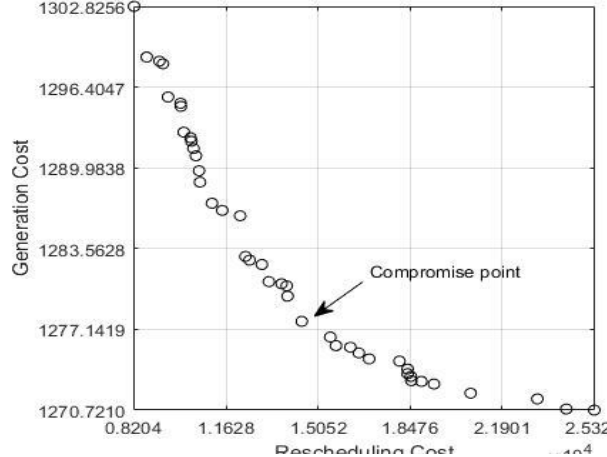
Figure 7. Convergence curve of Generation and Rescheduling Cost by MOPSO (Case 2)